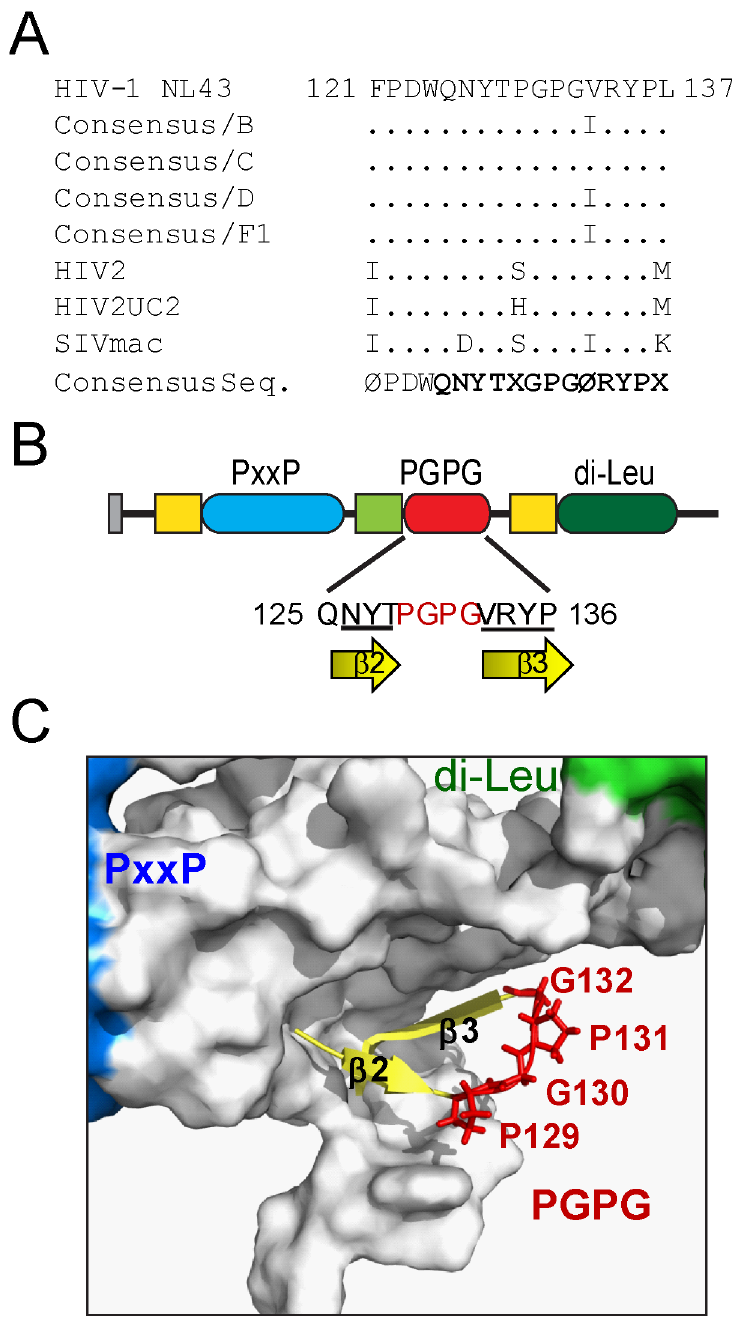
Fig 1. The GPG-loop is conserved among Nef proteins. A) Clustal W alignment of the 121 – 137 region of HIV1- Nef with homologous HIV2- and SIV-Nef sequences from Los Alamos database. The consensus sequence of the GPG-loop is highlighted to indicate the amino acid identity. X represents any amino acid residue and Ø represents a hydrophobic residue. B) Schematic representation of the domain organization of HIV-1NL4.3 Nef. The novel GPG-loop (red), conserved PxxP domain (blue), the di-Leucine based motif (dark green) as well as the membrane anchorage domain (grey), the acidic clusters (orange) and the dimerization domain (light green) are shown. C) Ribbon/surface diagram showing the HIV-1 Nef-GPG loop as generated by using the Pymol software (pdb2nef). The central GPG residues (red) are flanked by hydrophobic β 2 and β 3 sheets (yellow) in HIV-1 Nef structure. PxxP and di-Leucine motifs surfaces are coloured in blue or green, respectively.